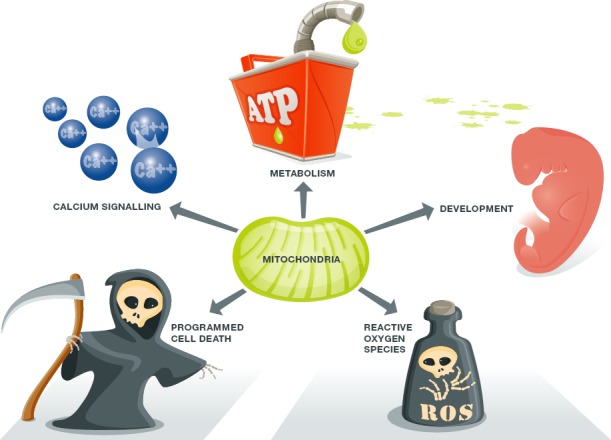
Schematic depiction of the extensive and varied impact of mitochondria on cell processesMechanistic details of how mitochondria produce ATP and ROS are shown in Fig2.